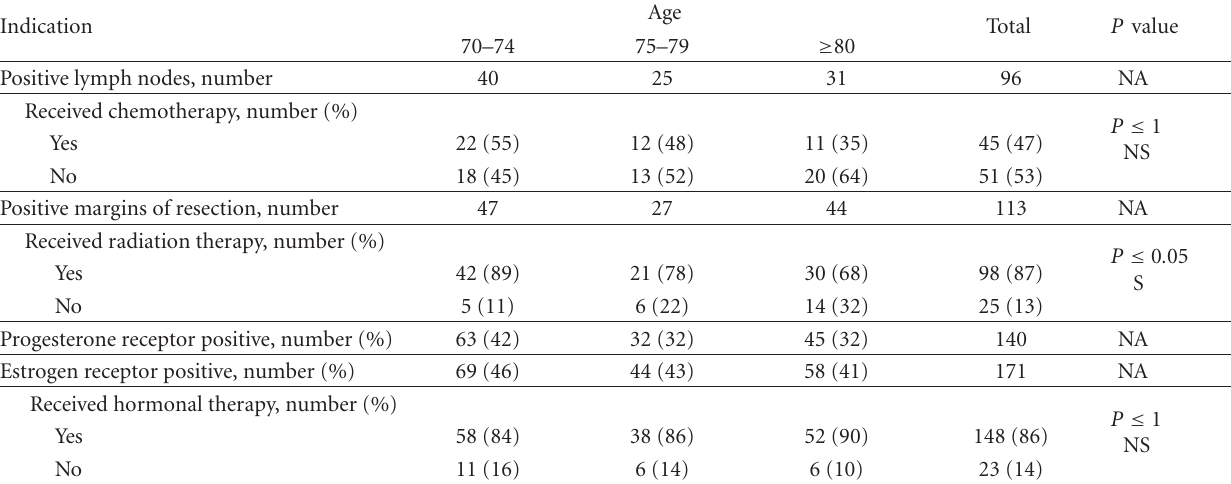
Table 3: Indications for adjuvant therapy and rates of treatment